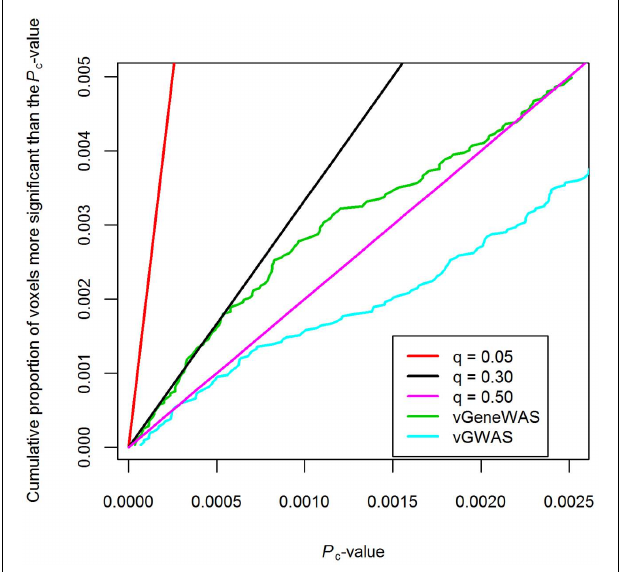
FIGURE 4 | Cumulative distribution function (CDF) plot of corrected p -values from vGeneWAS (Hibar et al., 2011) and vGWAS (Stein et al., 2010b) analyses. vGWAS could only be controlled for false-positives at q = 0.50 threshold, while vGeneWAS could be controlled for false-positives at q = 0.30.The difference in q -value thresholds for the CDF of the p -values obtained from both studies on the same dataset suggests that the gene-based analysis is more powerful, though neither study controlled the false-positive rate at the nominal q = 0.05 threshold.